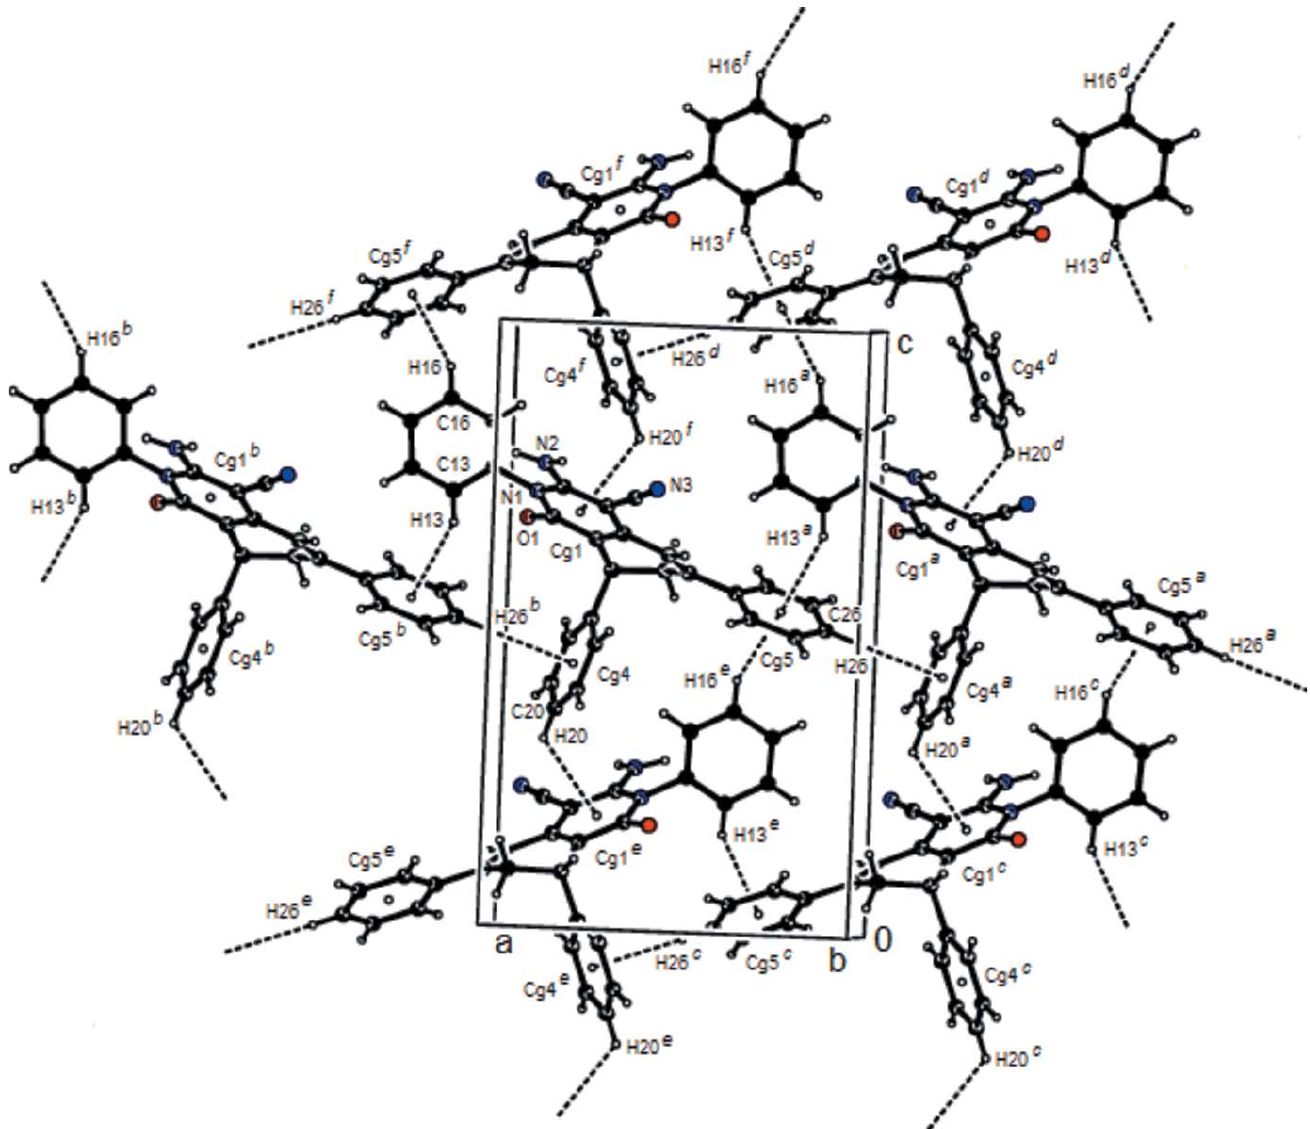
Figure 3 View of the C—H (cid:3)(cid:3)(cid:3) (cid:3) interactions of the title compound down the b axis. H atoms not involved in hydrogen bonding have been omitted for clarity. [Symmetry codes: ( a ) (cid:4) 1 + x , y , z ; ( b ) 1 + x , y , z ; ( c ) 1 are defined in Table 1.